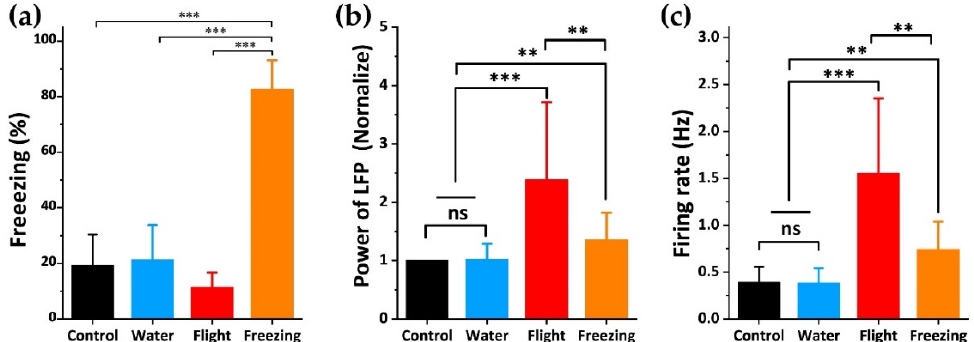
Figure 3. Quantitative analysis of main parameters of behavior and electrophysiology. ( a ) freezing percentage of rats during four different periods; ( b ) normalized power of LFP of rats during four different periods; ( c ) average firing rate of spikes of rats during four different periods. Results were expressed as mean ± SE. Statistical analysis was performed using Student’s t -test. ** p < 0.01, and *** p < 0.001.